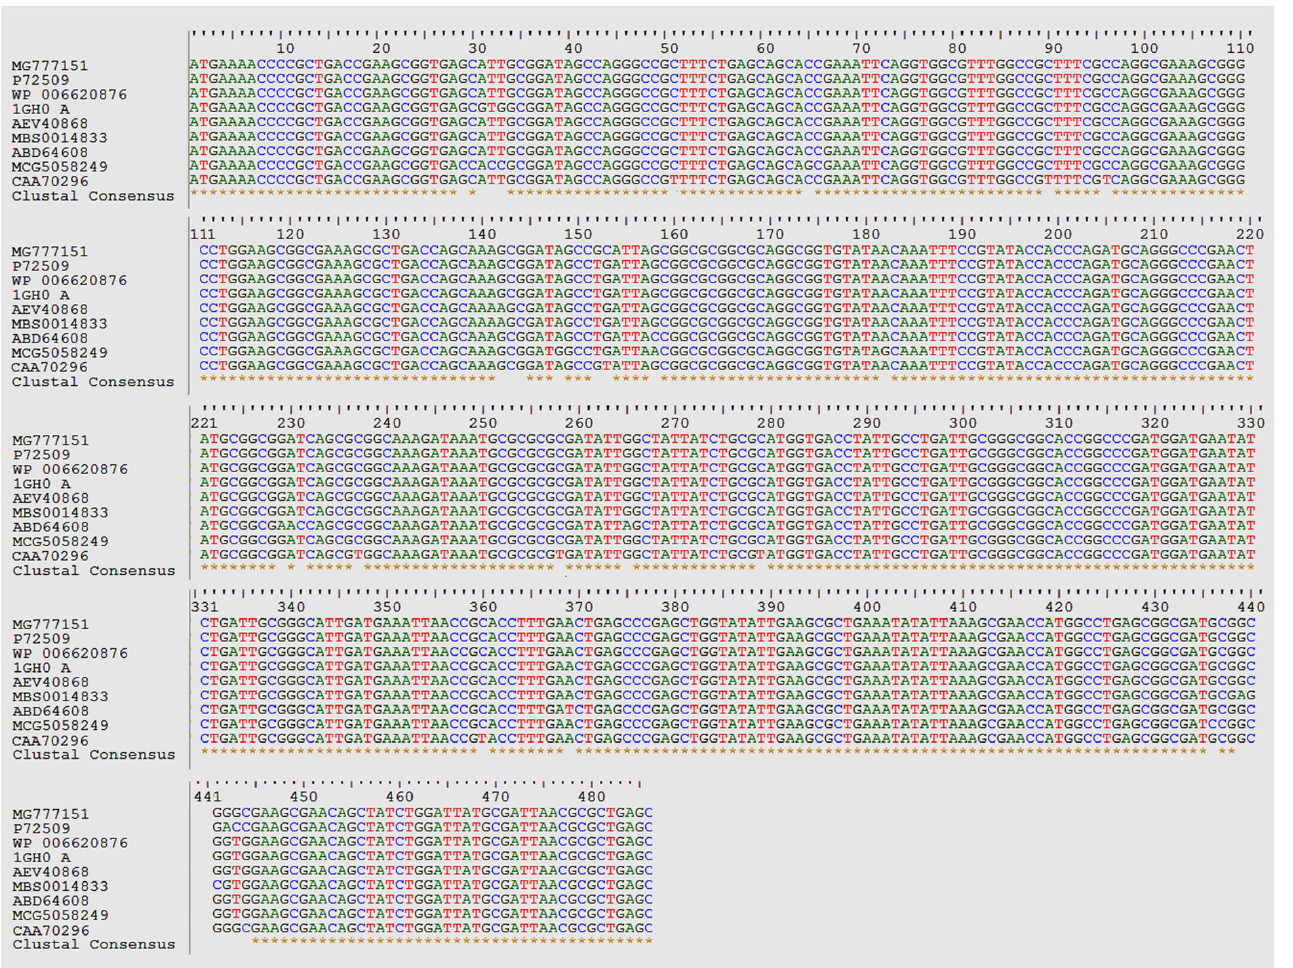
Figure 5. Multiple alignment of nucleotide sequences of phycocyanin subunit alpha of nine cyanobacterial species, including Arthrospira platensis strains and variants, using BioEdit. The letters A, T, C, and G symbolize the four nucleotides adenine, thymine, cytosine, and guanine, respectively; * represents conserved nucleotides.